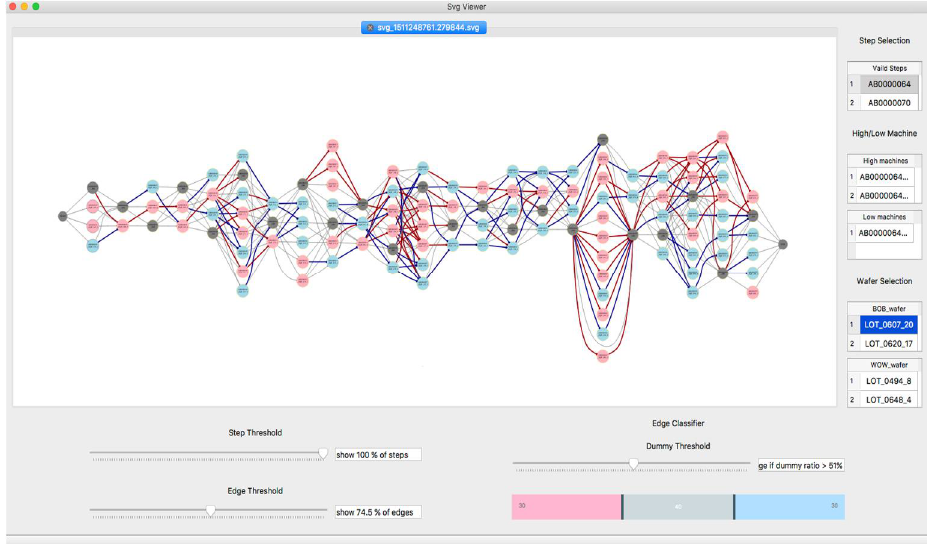
Figure 6. The interactive viewer in the implemented tool.